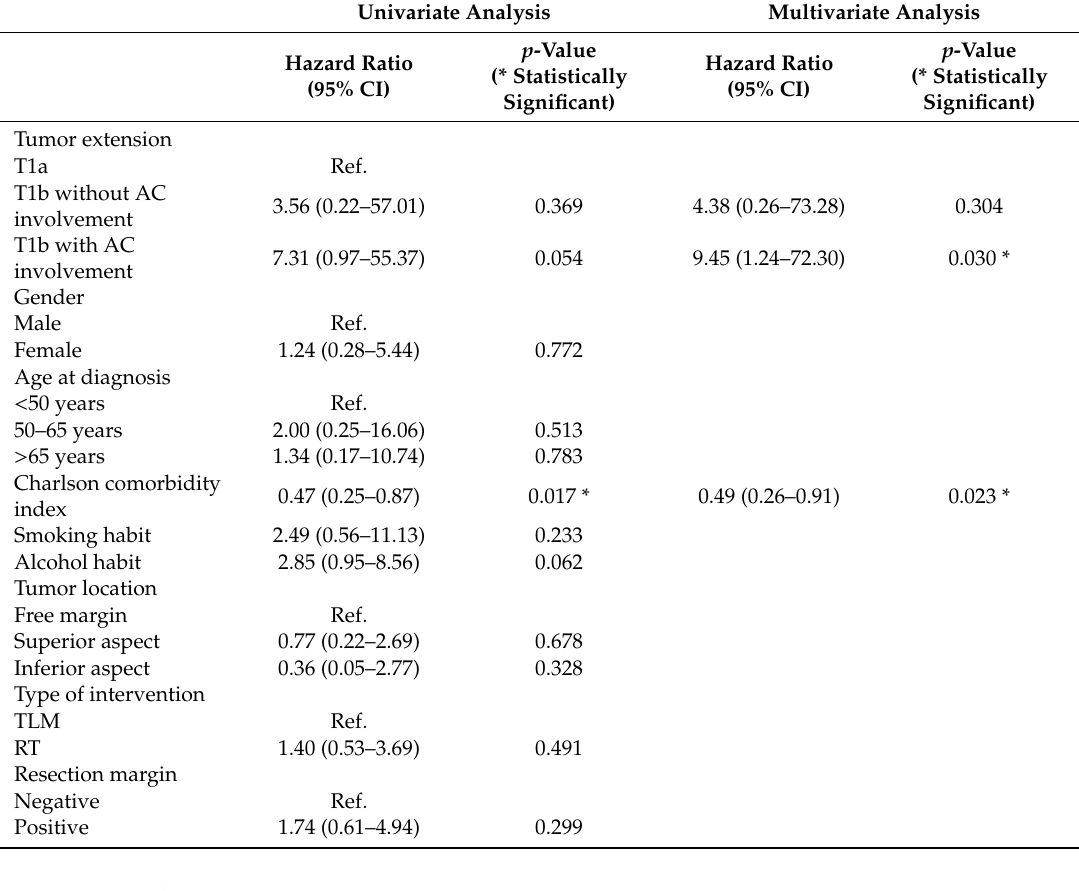
Table 4. Univariate and multivariate analyses of risk of recurrence.